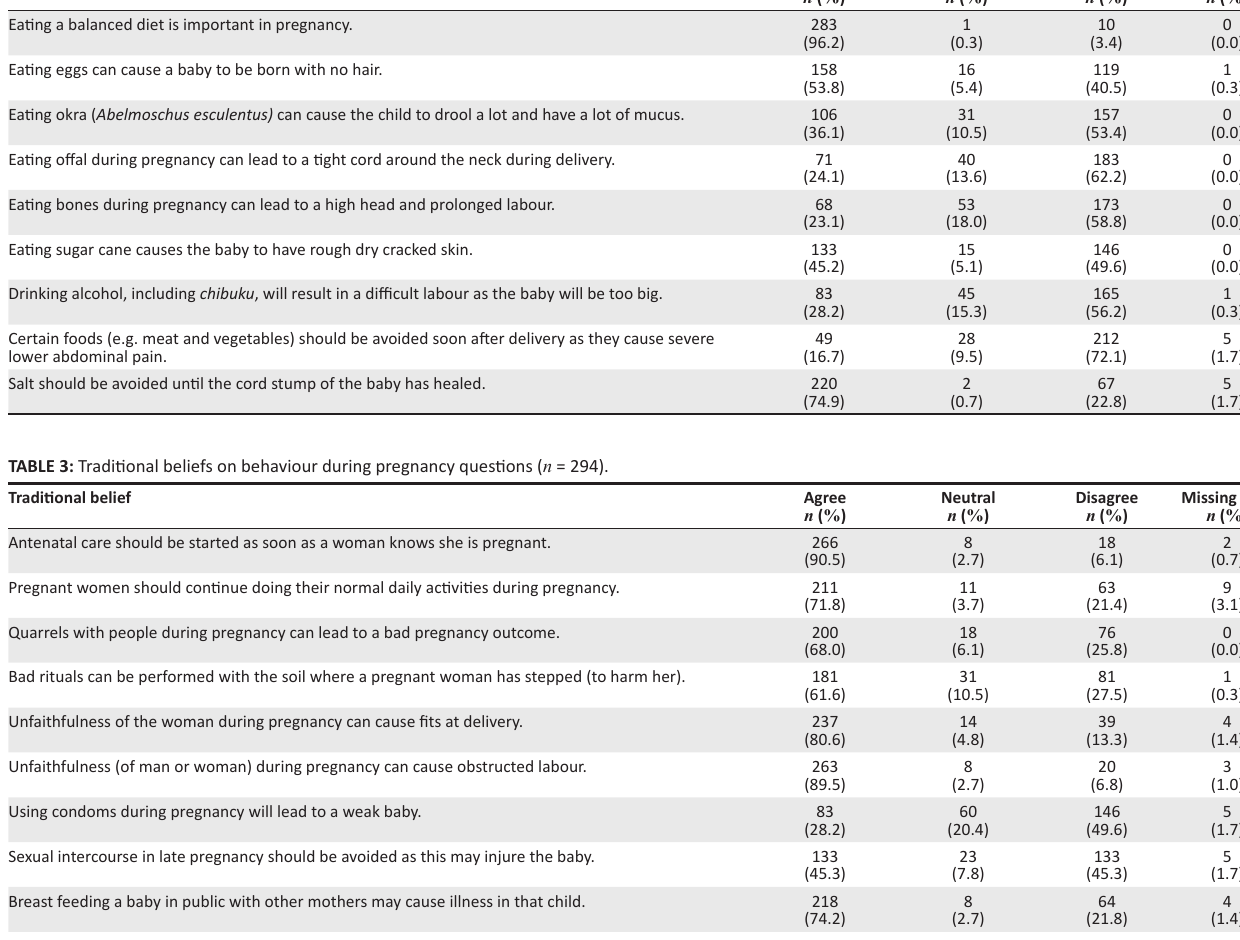
Neutral Disagree Missing data n ( % ) n ( % ) n ( % ) n ( % )